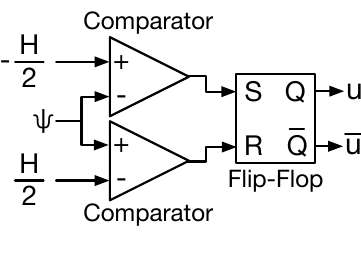
Figure 3. Switching